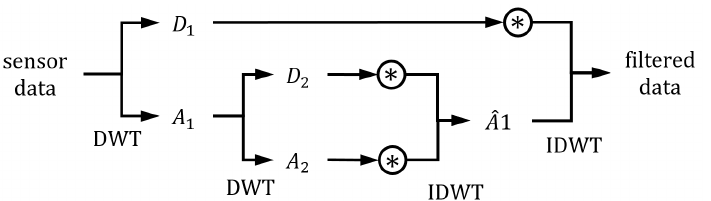
Figure 1. Structure of the wavelet reconstruction method. The convolution notation (asterisk with circle) represents the weighting process of the specific decomposed